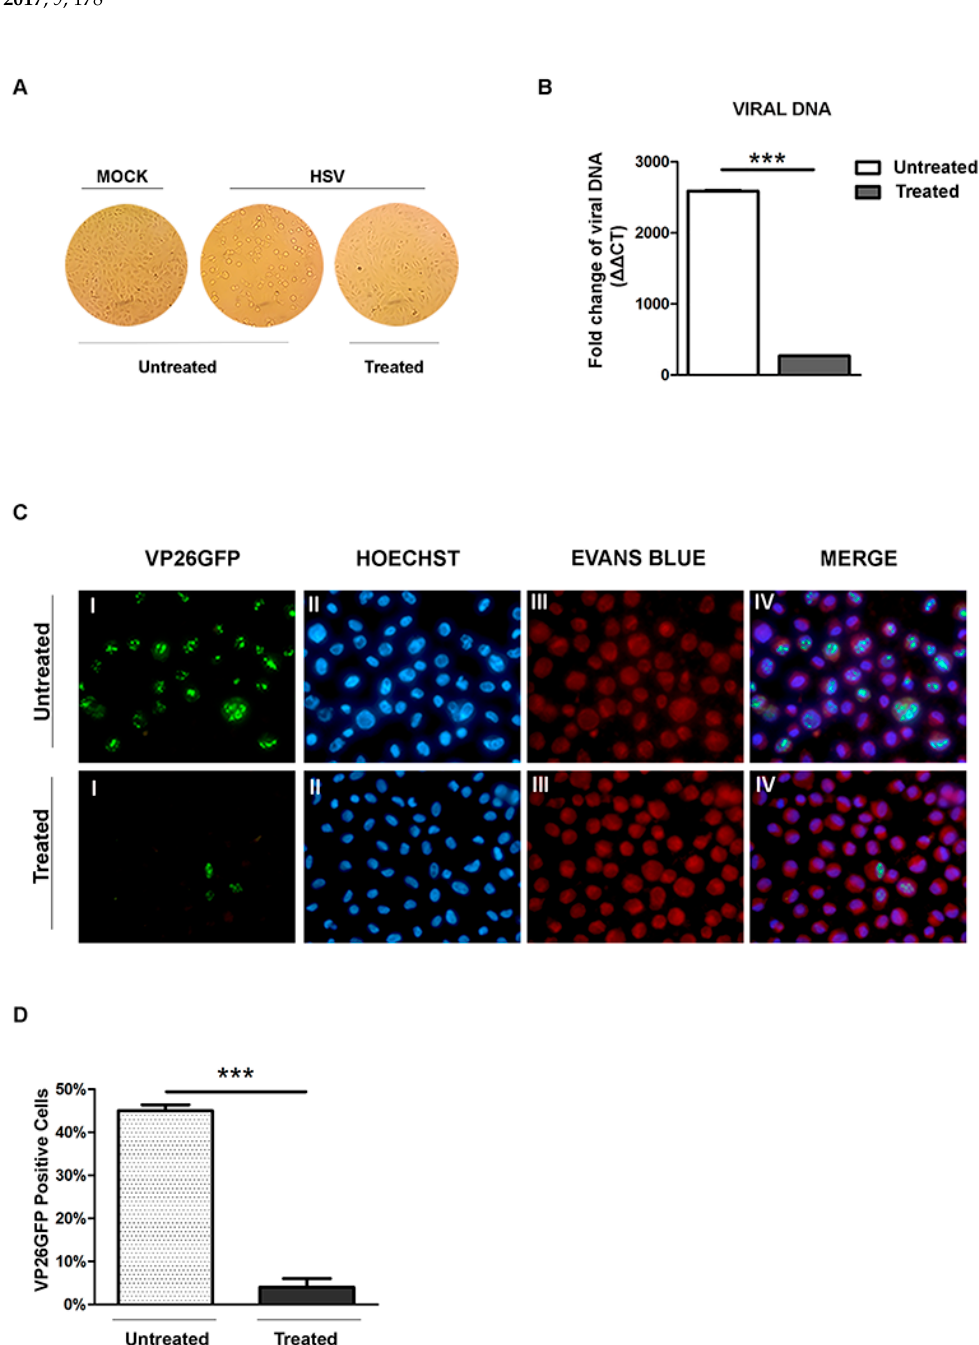
Figure 5. Effect of almond extract treatment on the HSV-1 binding. Vero cells infected and mock-infected with HSV-1 at low temperature and processed as described in the Material and Methods. ( A ) Normal phase contrast inverted micrographs of processed samples are shown. ( B ) Relative quantization of viral DNA of the processed samples are shown. Values represent ±SD of the average of three samples normalized against the GAPDH copies number and were analyzed by the comparative C t method ( ΔΔ C t ). ( C ) Fluorescent images of Vero cells infected with VP26GFP HSV-1 virus and following virus inactivation, untreated and treated with NS extract. The green dots (I) represent VP16GFP viral antigen localization. The cells were stained with Hoechst (II) for the nuclear compartment and Evans blue dye (III) as a counter-stain. The VP26GFP, Hoechst and Evans blue images are merged in the last columns (IV). ( D ) Schematic representation of the VP26GFP-positive cells. *** p < 0.001 indicates significant changes.